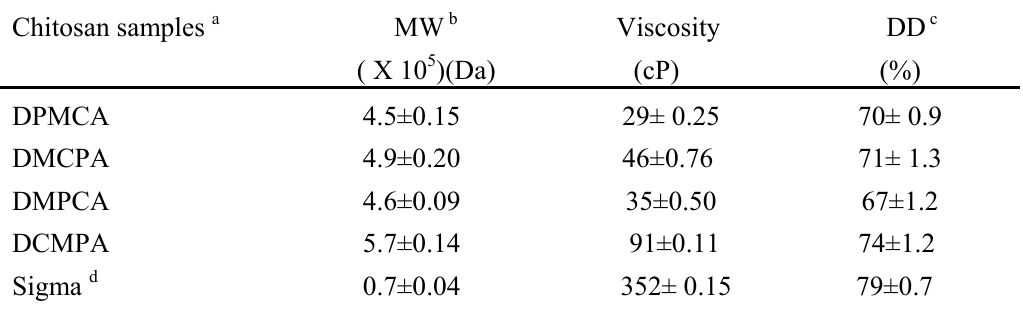
Table 2. MW, viscosity and DD of A. urmiana and commercial chitosan